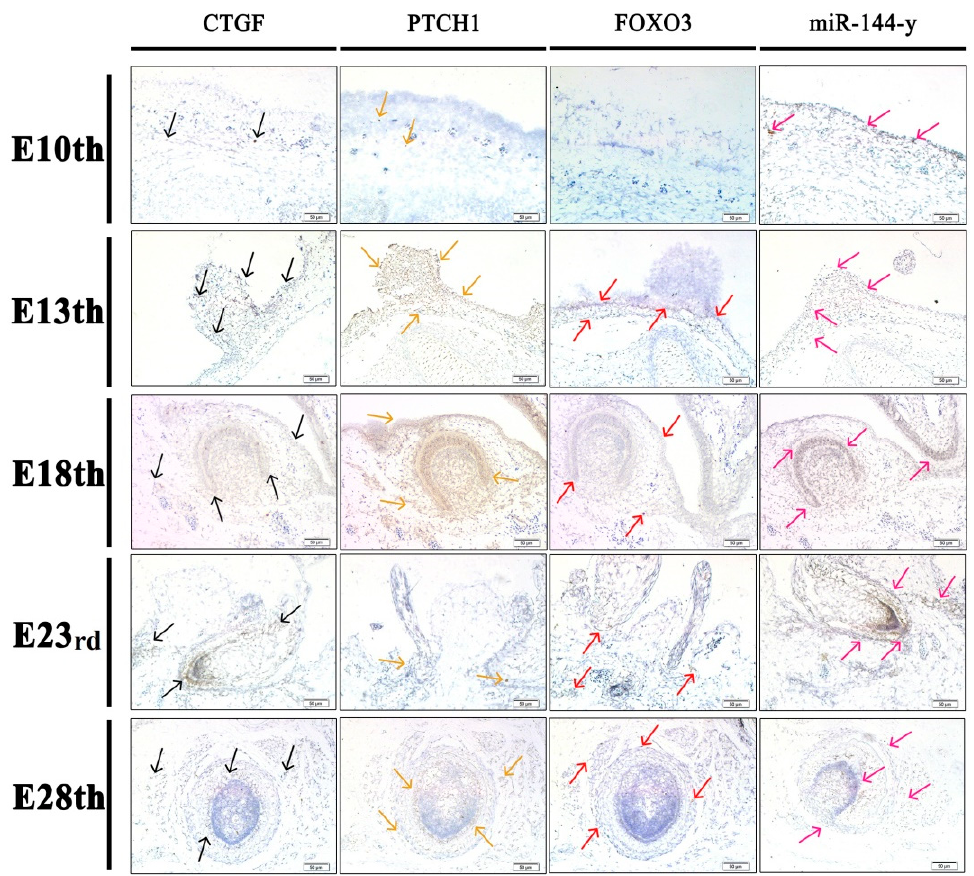
Figure 7. In situ hybridization of selected genes and miRNA. The horizontal column shows the mRNA/miRNA expression localization of CTGF, PTCH1, FOXO3, and miR-144-y, and the vertical column shows the expression based on different embryonic stages. Magnified: 20 × ; Bar: 50 µ m.